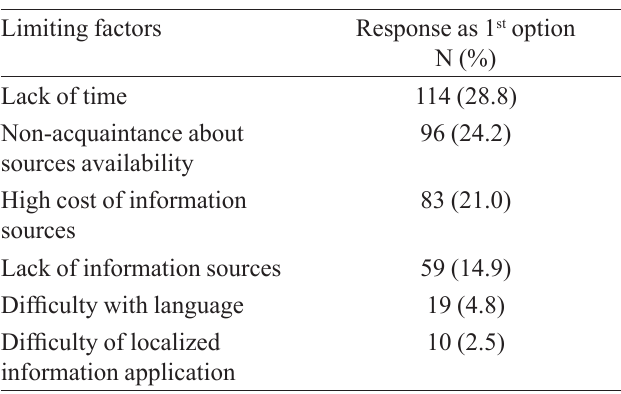
TABLE IV – Information search limiting